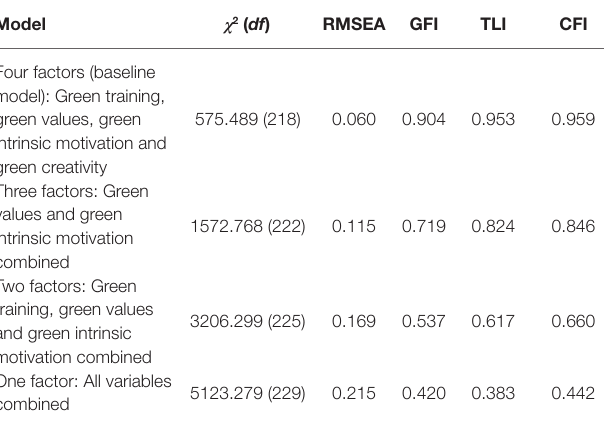
TABLE 1 | Comparison of measurement